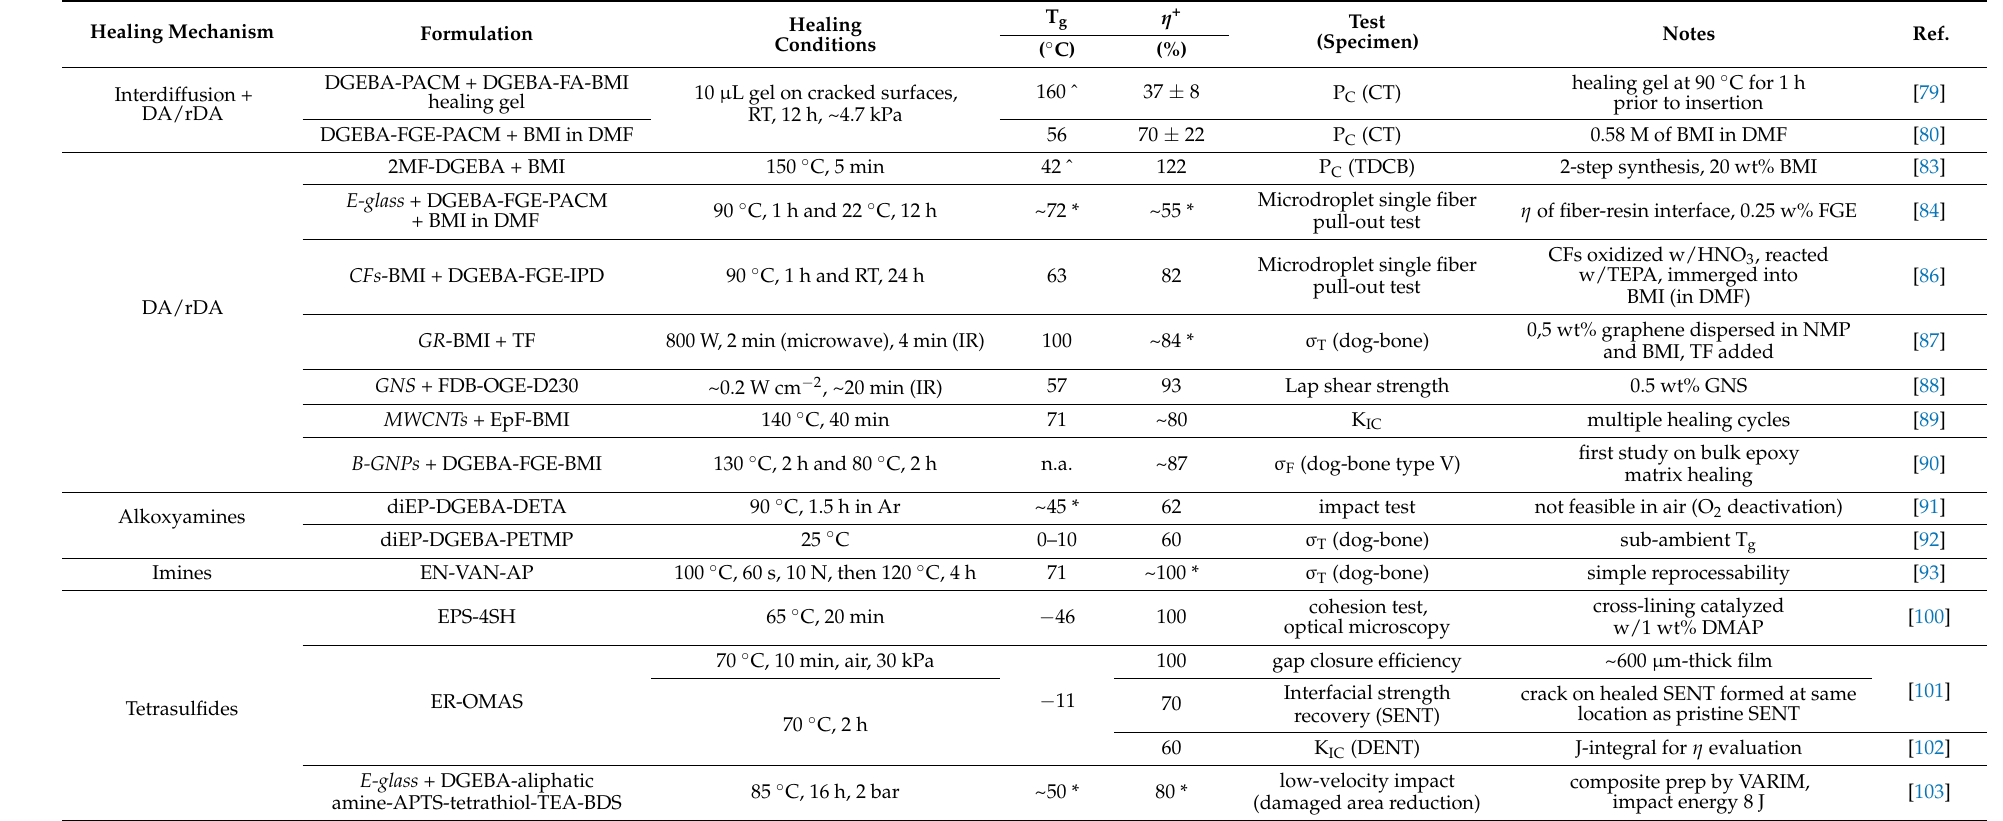
Table 3. Summary of intrinsic self-healing formulations via chemical